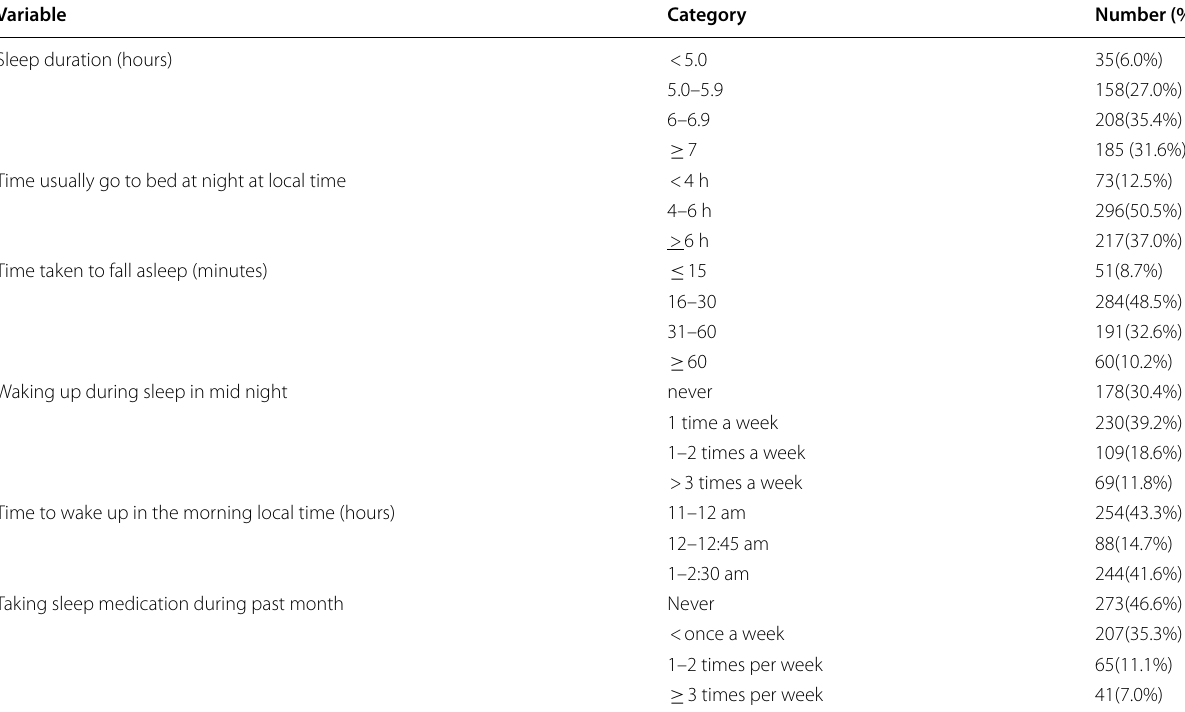
Table 2 Distribution of sleeping pattern among Haramaya University students, Eastern, Ethiopia, 2020